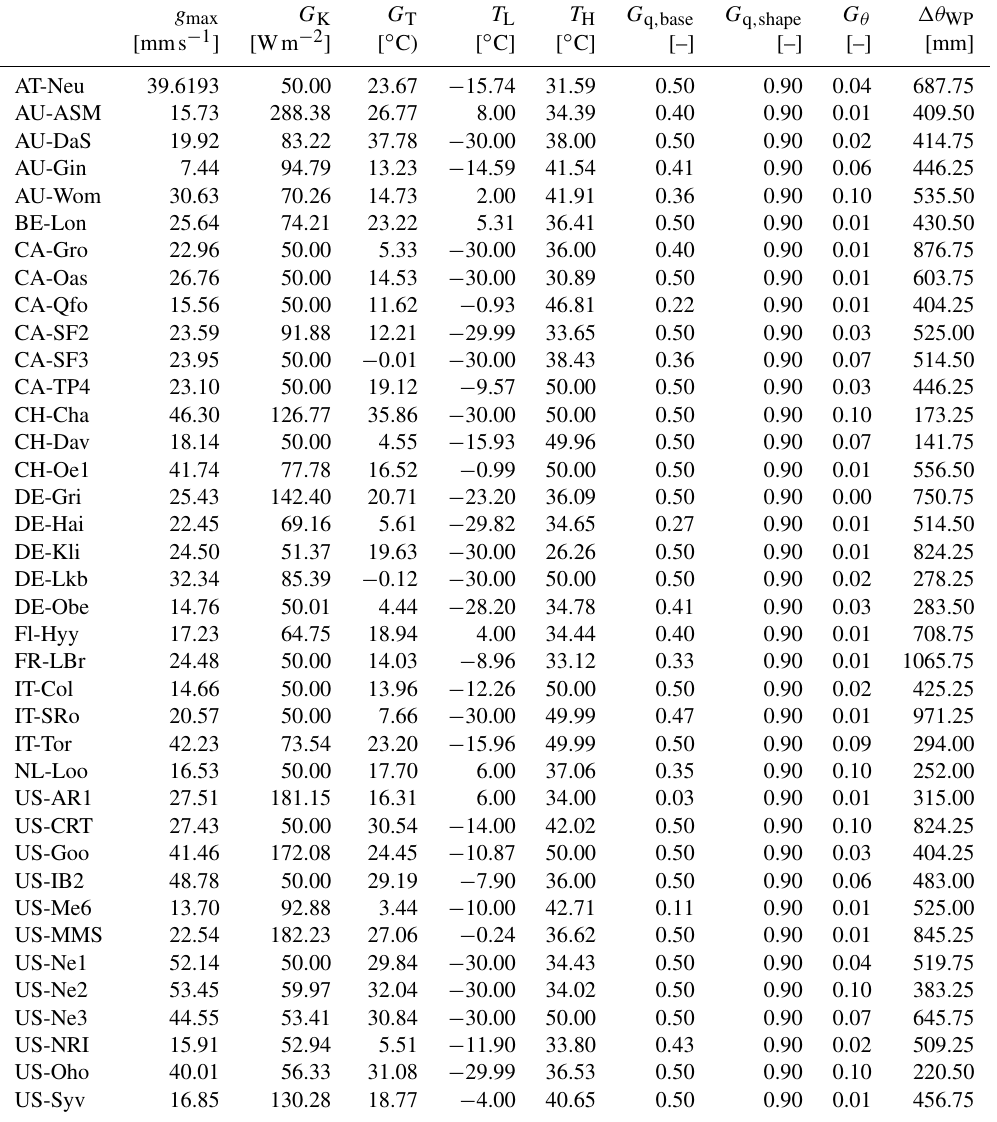
Table C3. As Table C1, but for surface-conductance-related parameters (Sect.